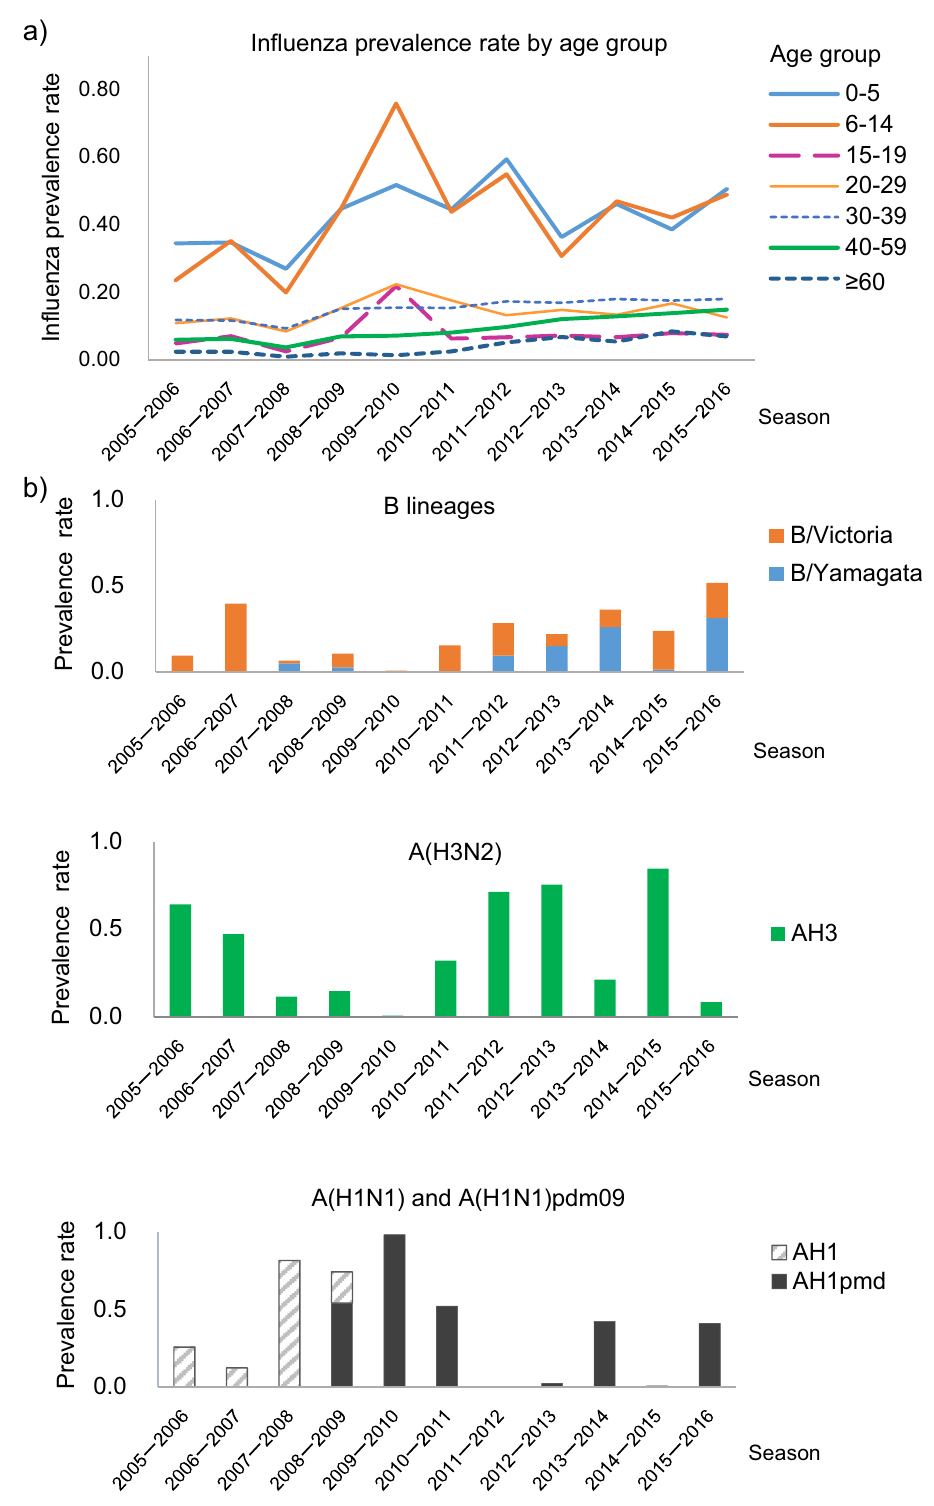
Figure 1. Influenza prevalence rate by age group and predominant virus. ( a ) Prevalence rate by age group according to reports from national sentinel clinics for each season. The base population was calculated using data from the national census in 2010. The 2005–2006 season comprised only data between January and June 2006 (due to data availability). ( b ) Prevalence of cases attributable to each epidemic virus subtype and strain (concerning B lineages, the prevalence of unspecified B lineages was distributed for the ratio of the B/Victoria and B/Yamagata lineages in each